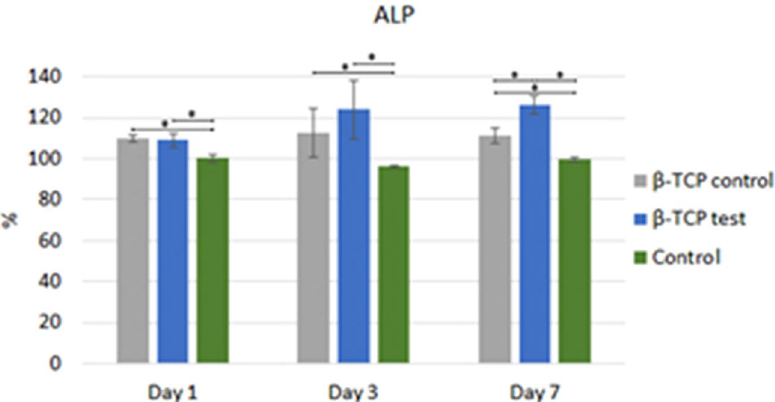
Figure 8. ALP analysis. Statistically significant difference indicated by * P < 0.05.